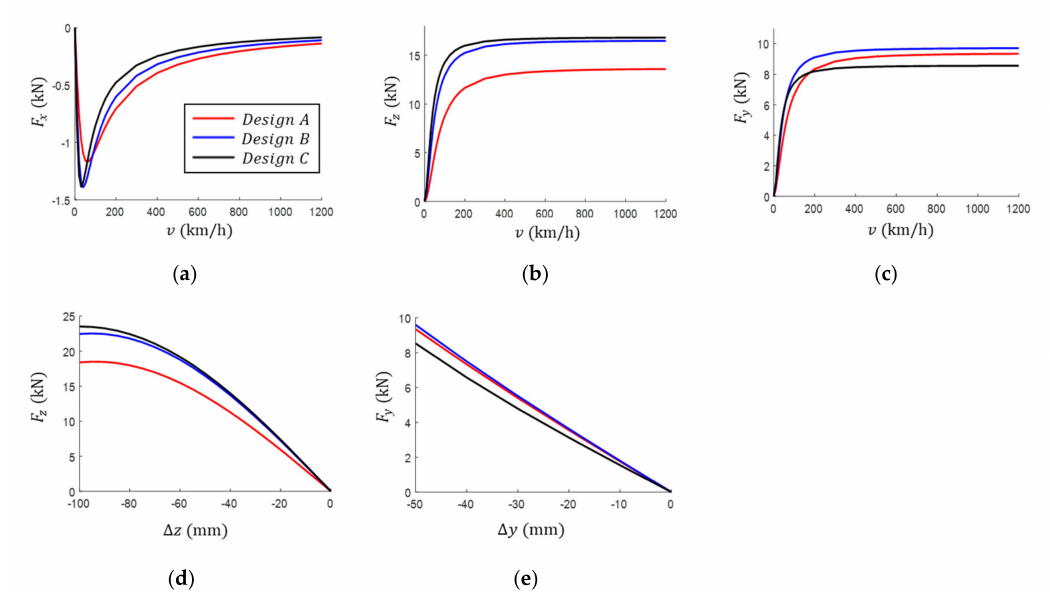
Figure 21. Calculated forces using the SLC with the L e applied when the driving speed or position of the SCM change: ( a ) drag and ( b ) lift force with the change in the SCM speed driving at ∆ y = 0 and ∆ z = − ∆ z max /2, ( c ) guidance force with the change in the SCM speed driving at P y , ( d ) lift force with the change in the vertical displacement when driving the horizontal center at v h , and ( e ) guidance force with the change in the horizontal displacement when driving ∆ z = − ∆ z max /2 at v h